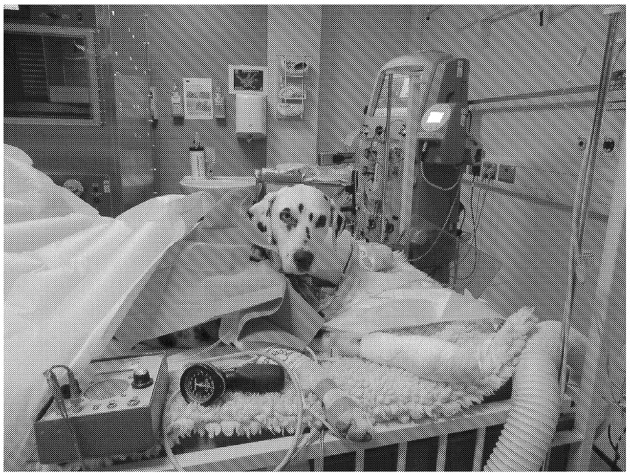
Patient undergoing a plasma exchange (PEX) cycle. Permission for publication of this image was obtained by the clients. In the background, the extracorporeal plasma filtration unit can be seen (Prismaflex®;Gambro).